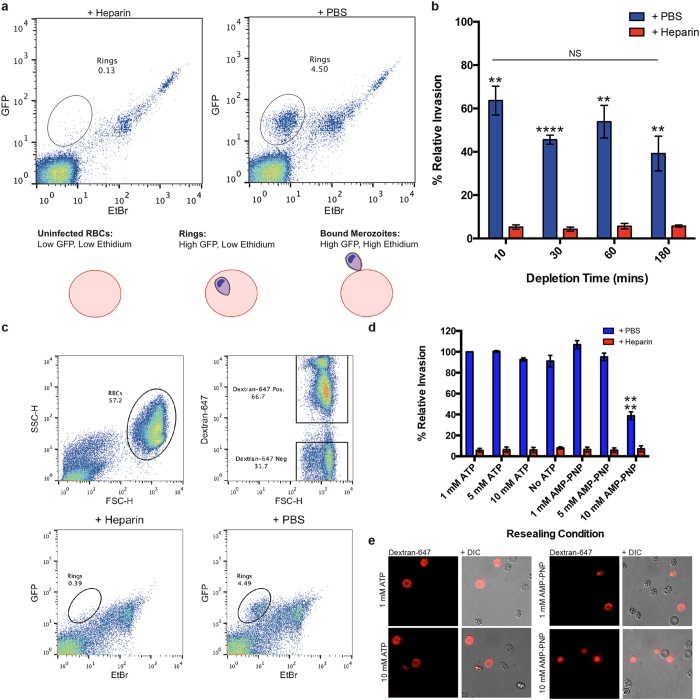
Erythrocyte ATP is required for merozoite invasion.(a) Method for quantifying merozoite invasion by flow cytometry. Free GFP-expressing merozoites are added to fresh erythrocytes in a 96-well plate format under agitation for 40 min. Samples are stained with ethidium bromide (EtBr), which labels the parasite nucleus, washed and run on a flow cytometer using a high-throughput plate reader. After gating on erythrocytes, the proportion of red blood cells invaded by merozoites can be quantified. Erythrocytes alone are GFP and EtBr low, while red blood cells with associated parasites and free merozoites are GFP high. EtBr distinguishes between erythrocytes with bound extracellular merozoites, which stain high, and those infected with new rings, which stain low. Here, a new ring-stage parasitemia of 4.5% was achieved, a population that is absent when the invasion assay was performed in the presence of the invasion inhibitor heparin. (b) Invasion rate into cells depleted of ATP for different amounts of time, where invasion is expressed as a percentage relative to the new ring parasitemia of control cells that were incubated in PBS alone. **p < 0.05, ***p < 0.01, ****p < 0.0001, NS = non-significant difference, two-tailed unpaired t-test. Graph displays mean +/−SEM. n = 3 in triplicate. (c) When free D10-PHG merozoites are added to resealed erythrocytes and stained with EtBr, dextran-Alexa647 allows quantitation of invasion into resealed cells by flow cytometry. (d) Invasion rate into erythrocytes resealed in the presence of different concentrations of either ATP or AMP-PNP, where invasion is expressed as a percentage relative to the new ring parasitemia of control cells that were resealed in the presence of 1 mM ATP. ****p < 0.0001, two-tailed unpaired t-test. Graph displays mean +/−SEM. n = 3 in triplicate. (e) Live imaging of erythrocytes resealed under different conditions, where dextran-Alexa647 marks successfully resealed cells.